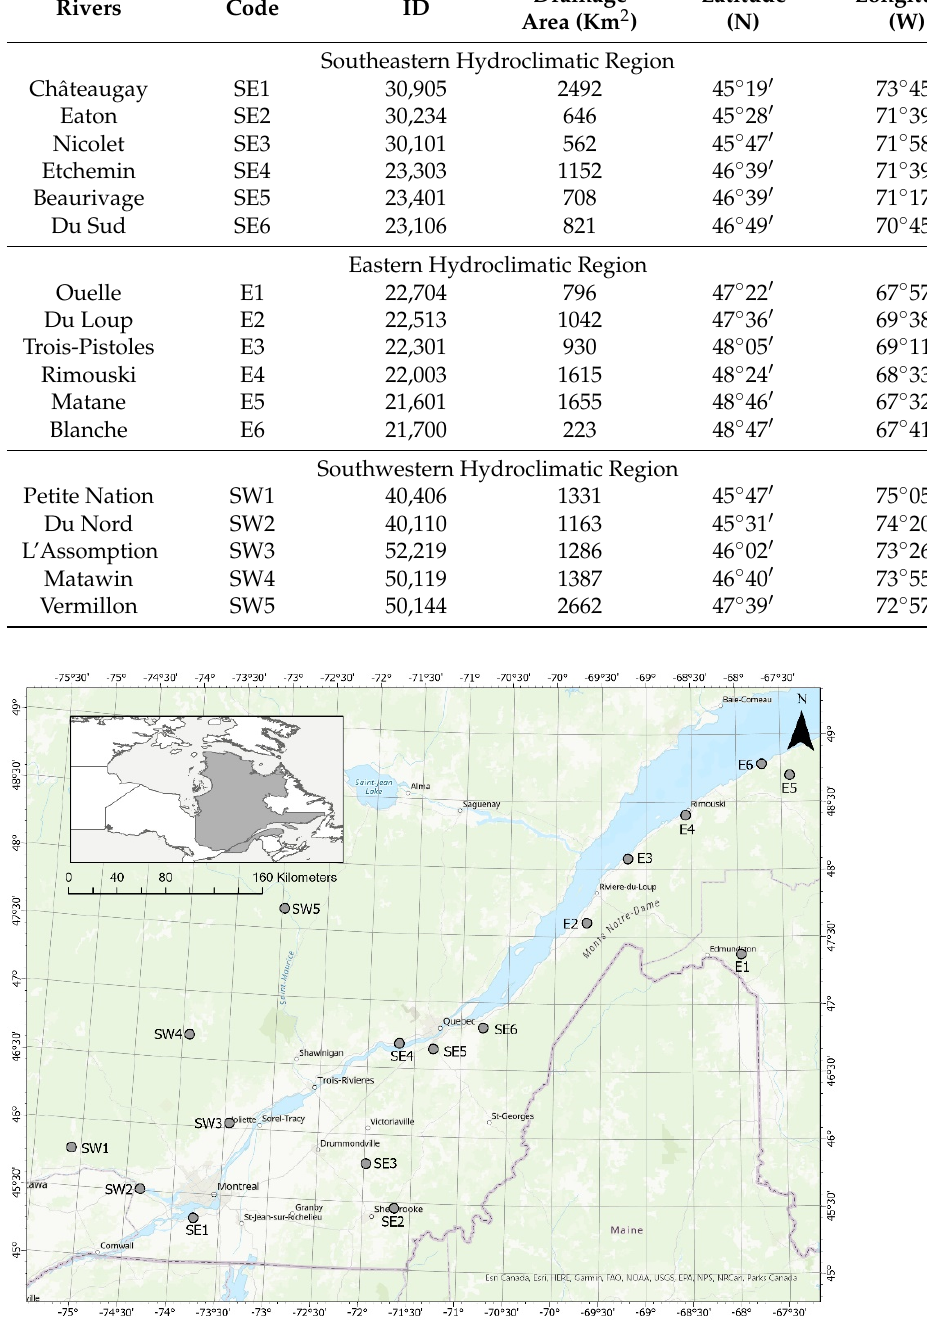
Figure 1. Locations of the river stations. SE = Southeastern Hydroclimatic Region; E = Eastern Hydroclimatic Region; SW = Southwestern Hydroclimatic Region. Table 1. Description of the stations studied.